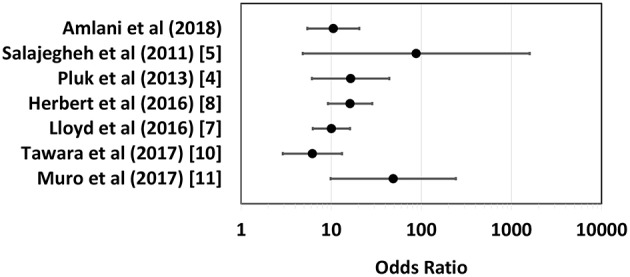
Logarithmic forest plot for diagnostic odds ratios showing data from six anti-NTc51A studies with available sensitivity and specificity data. Error bars indicate 95% confidence intervals. For detailed plot data see Supplemental Table 1.